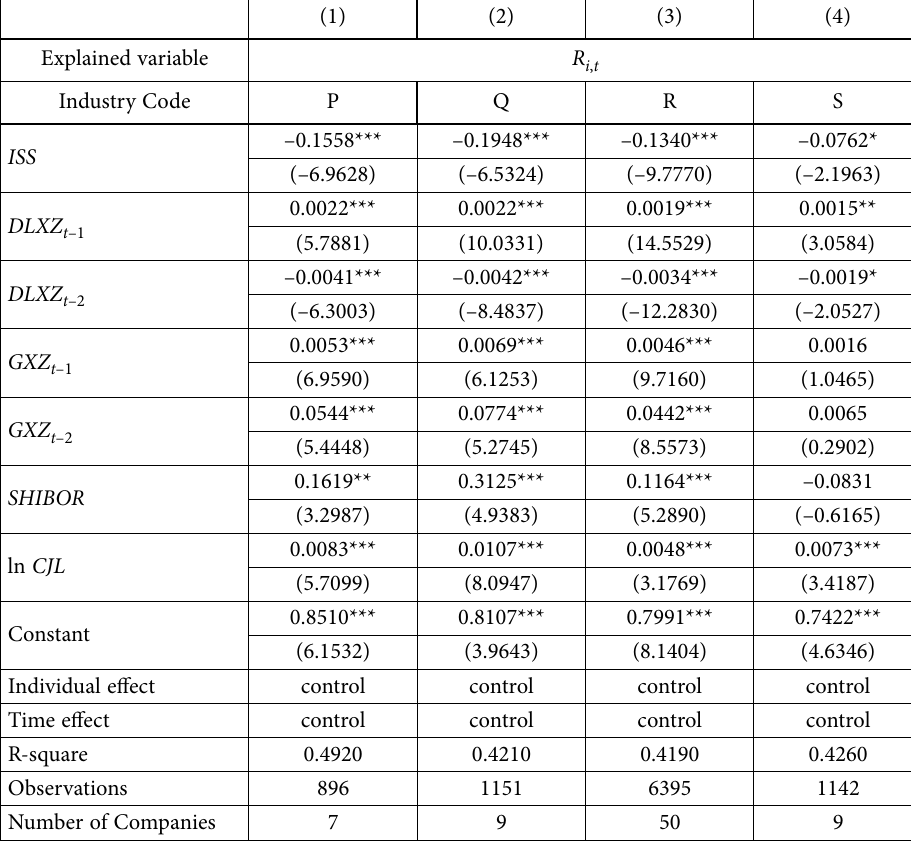
Table 11. Influence of information infection on stock market